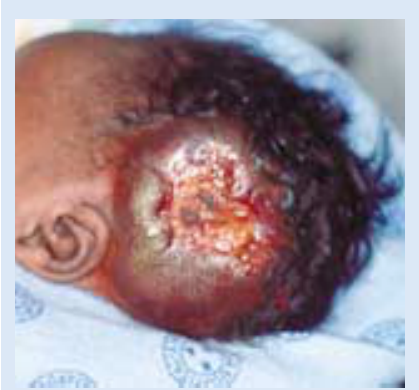
Fig. 1c. Ulceration of scalp haemangioma.